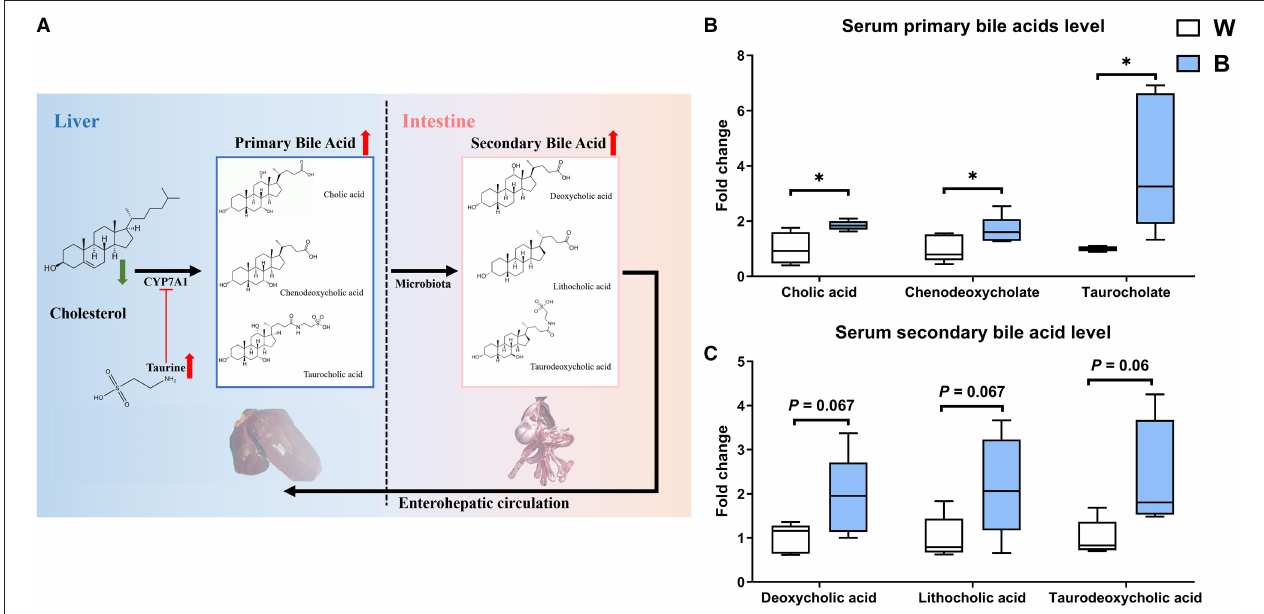
FIGURE 5 | Exposure to blue light promotes bile acid synthesis. (A) Effects of blue light on synthesis and secretion of primary and secondary bile acids in ducks. (B) Effects of blue light on primary bile acid levels of cholic acid, chenodeoxycholic acid, and taurocholic acid in ducks ( n = 6, mean with SEM). (C) Effects of blue light on secondary bile acid levels of deoxycholic acid, lithocholic acid, and taurodeoxycholic acid in ducks ( n = 6, mean with SEM). Data in (B,C) were analyzed using the unpaired t -test, * P <